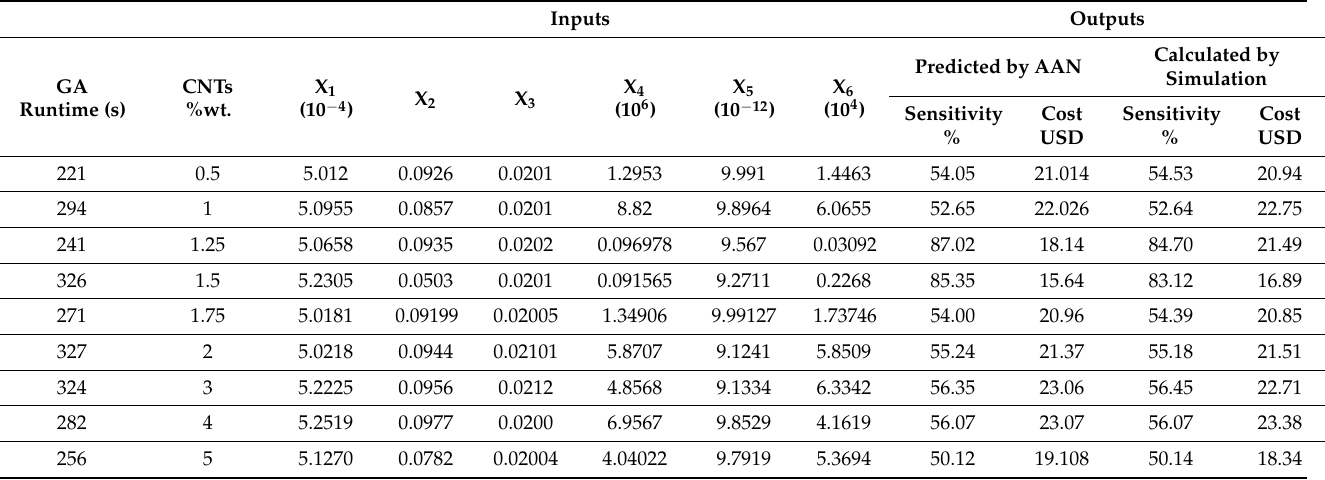
Table 4. Detailed value for decision variables and objective functions of Pareto Frontier best points for different CNTs %wt.